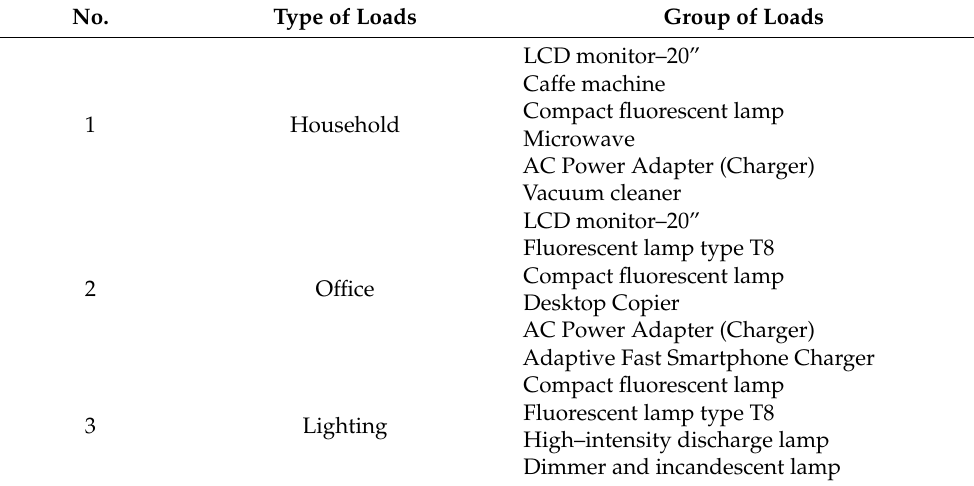
Table 2. Selected sets of equipment.